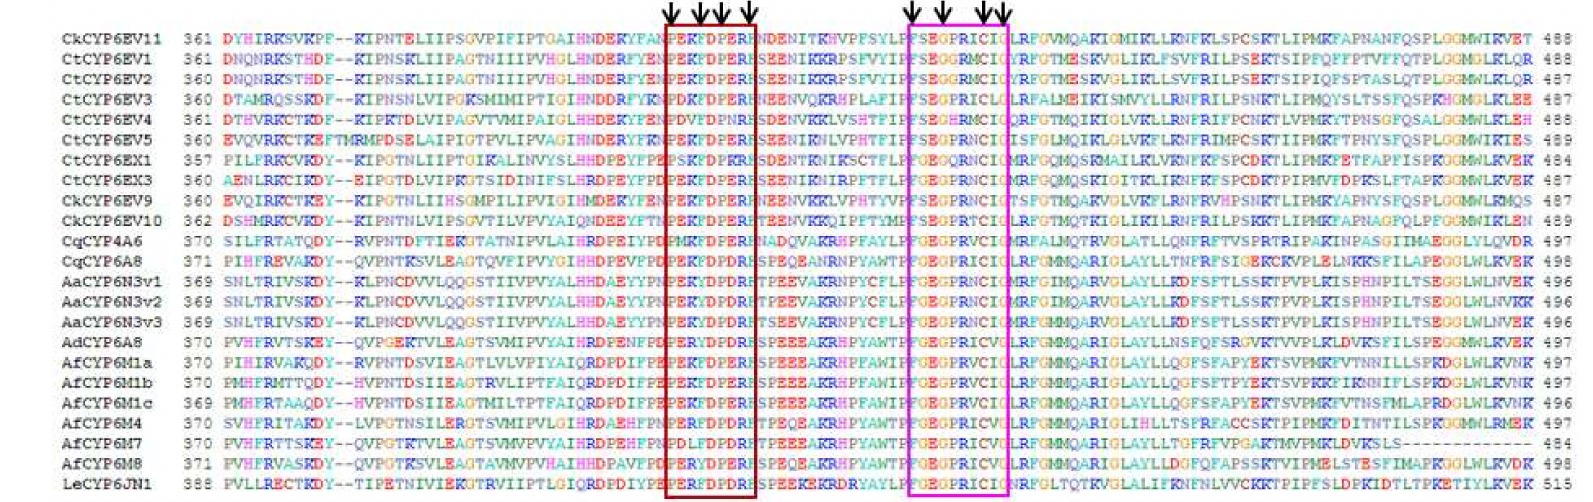
Figure 2. The alignment of deduced amino acid sequences from 23 CYP genes from seven insects. The five important conserved motifs of the CYPs were framed by only partial sequence alignment. The purple box shows helix-C with conserved sequences WxxxR; blue box indicates helix-I with typical sequences AGxET; and dark box highlights helix-K with sequences E/SxLR. The heme-binding domain is boxed in pink with typical residues FxxGxxxCxG/A and the conserved Meander domain was boxed in red with conserved sequences PxxFxPxxF. The similarity of CYP6EV11 with CkCYP6EV10 , CtCYP6EV4 , CtCYP6EV5 , CkCYP6EV9 , CtCYP6EV2 , CtCYP6EV3 , CtCYP6EV1 , CtCYP6EX3 , AfCYP6M8 , CqCYP6A8 , AfCYP6M4 , AdCYP6A8 , AaCYP6N3v3 , AaCYP6N3v2 , AaCYP6N3v1 , AfCYP6M7 , CqCYP4A6 , AfCYP6M1b , AfCYP6M1a, CtCYP6EX1 , LeCYP6JN1 , AfCYP6M1c is 71%, 64%, 63%, 61%, 58%, 56%, 56%, 47%, 43%, 44%, 44%, 43%, 42%, 41%, 42%, 43%, 42%, 45%, 45%, 44%, 41%, 44%,